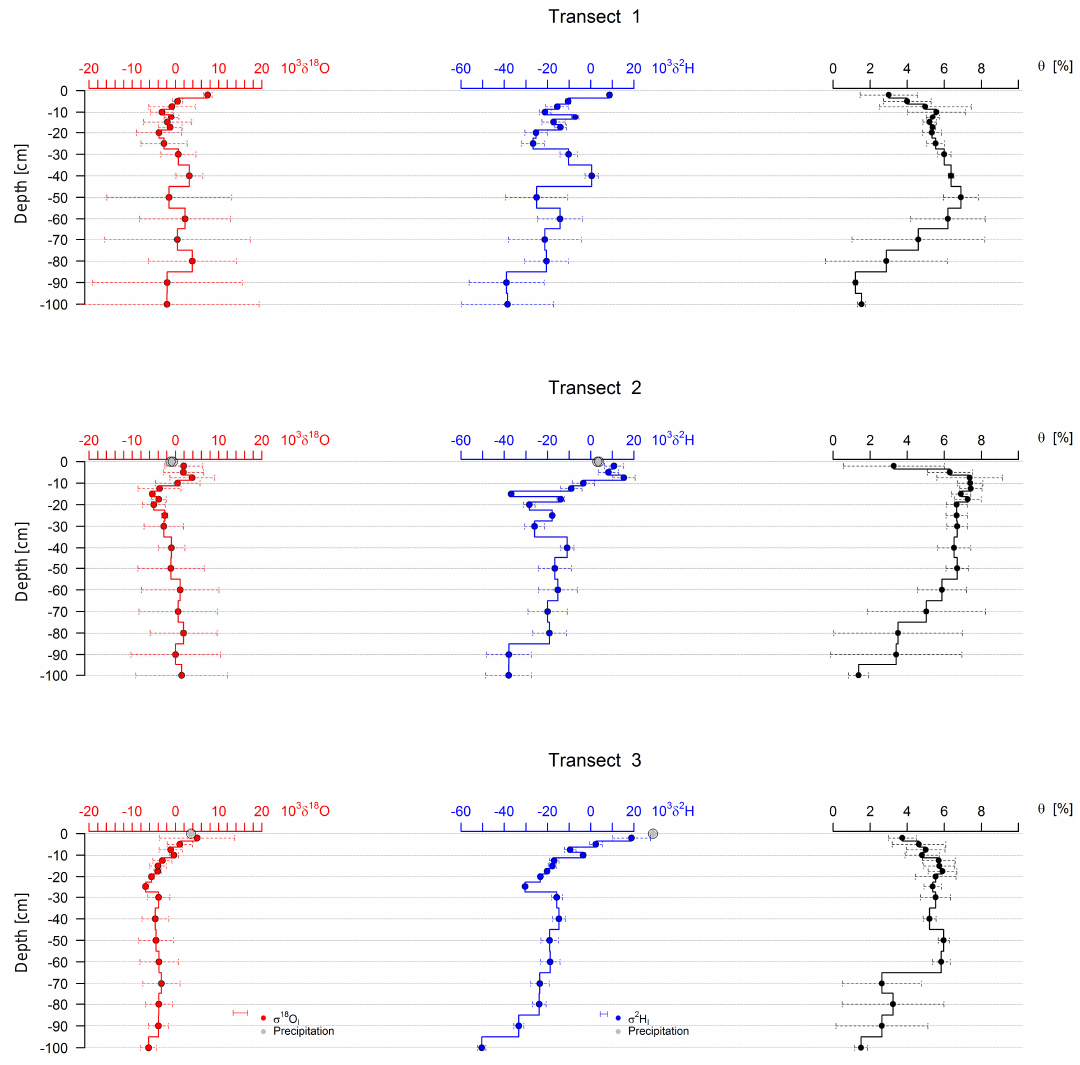
Figure 6. 18 O (red), 2 H (blue), and soil moisture (black) depth profiles. Shown are mean values for three transects consisting of three single profiles derived from in situ measurements. Mean standard deviation σ of all quality check standards (qc) is shown in the legend. Rainfall isotope values are indicated on the x axes in grey.